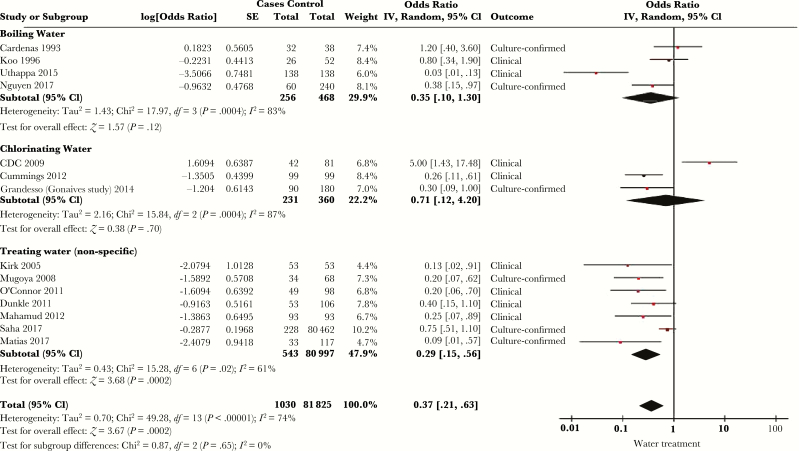
Forest plot of studies included in meta-analysis assessing whether water treatment was associated with symptomatic cholera. Studies were stratified by whether they assessed chlorination, boiling, or nonspecific report of water treatment. The summary odds ratio was calculated using random effects models. Heterogeneity is described using the Cochran Q test and the I2 statistic. Abbreviations: CI, confidence interval; df, degrees of freedom; IV, inverse variance; SE, standard error.